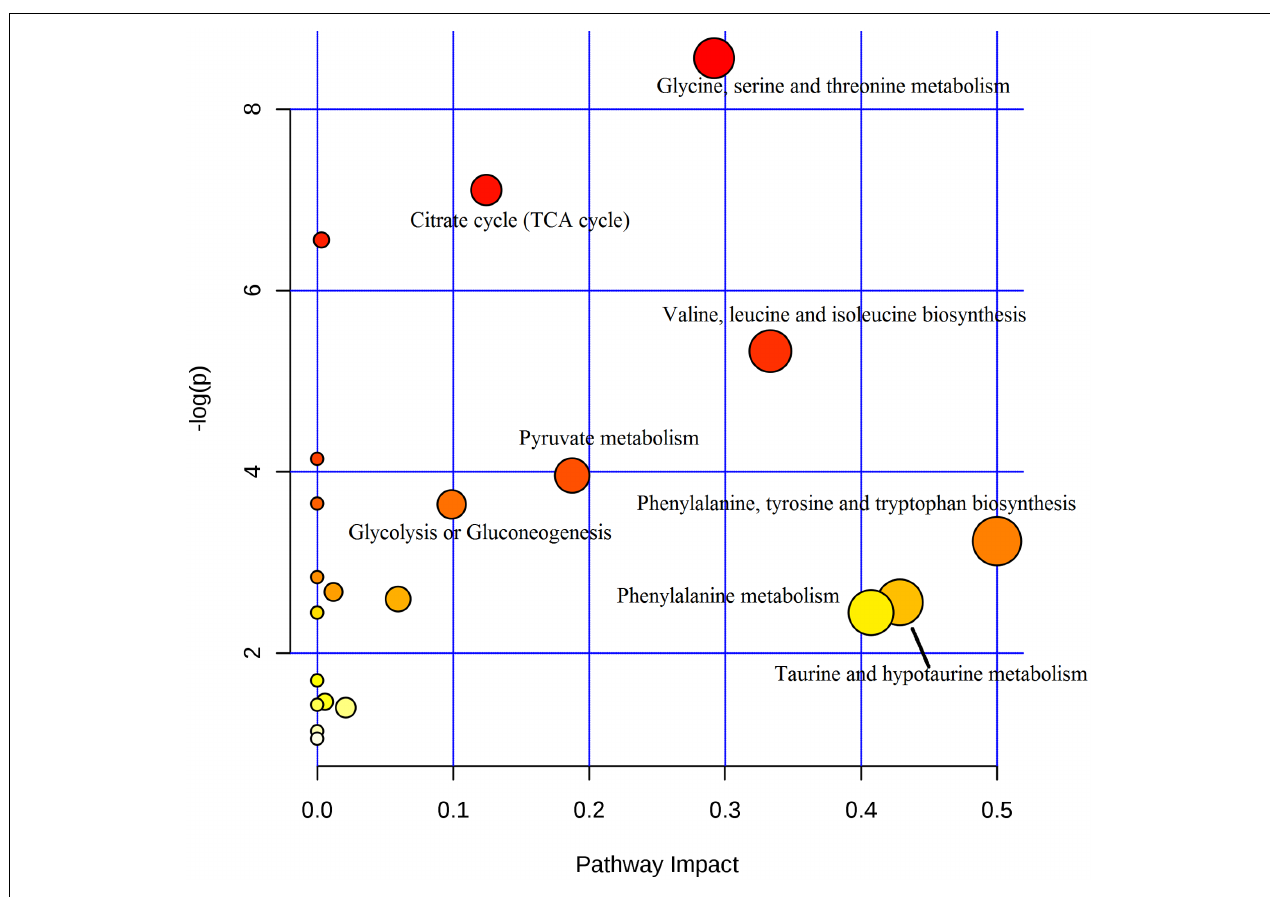
FIGURE 5 | The summary of pathway analysis. The X axis represents pathway impact, and the Y axis represents the − log (p).